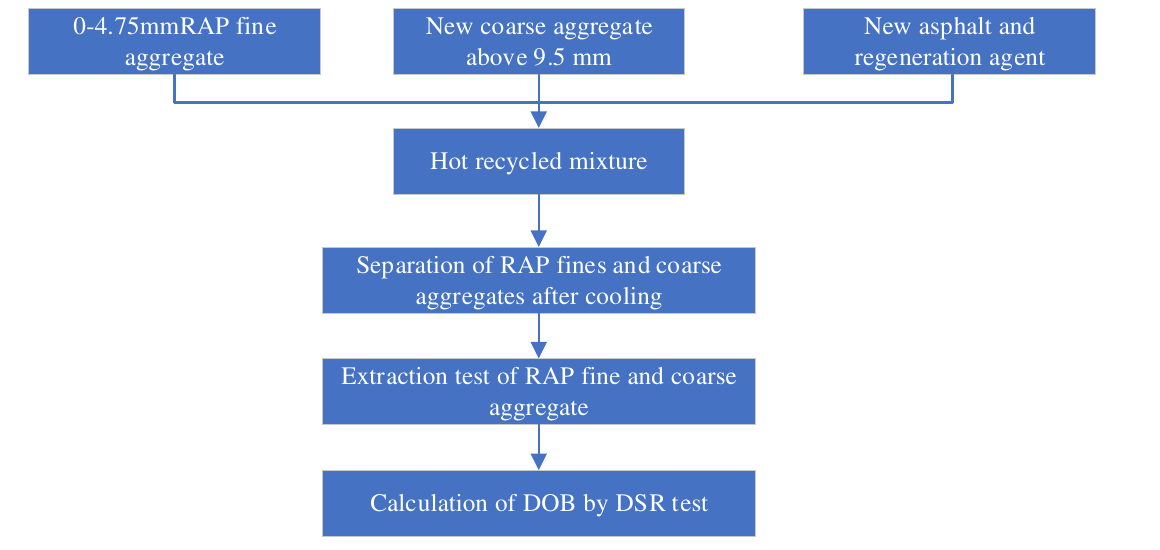
Figure 2. Diagram of DOB test scheme.